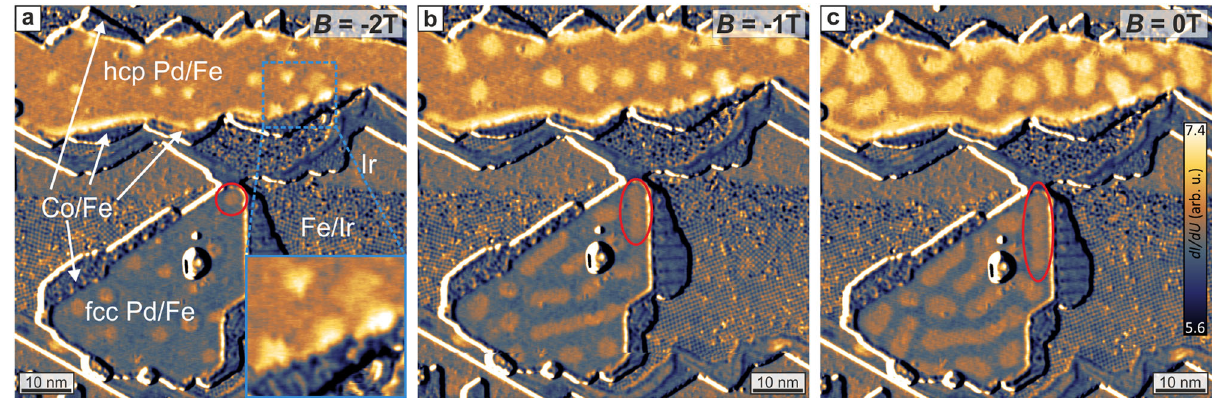
Fig. 3 Remanent skyrmions after magnetic fi eld-sweep. a Two differently stacked Pd/Fe islands surrounded by Co/Fe in an external fi eld B = − 2 T; skyrmions can be written or deleted by scanning the sample surface with a suf fi ciently high bias voltage 6 . Inset shows a zoom-in of the magnetic objects at the island rim. b The same two islands after reducing the external fi eld to B = − 1 T. c Final image at B = 0 T; Many skyrmions have survived and are now in a metastable state. A skyrmion performing a partial strip-out parallel to the island edge is encircled in red. All differential conductance (d I /d U ) maps: tunneling current I = 3 nA, bias voltage U = 20 mV.